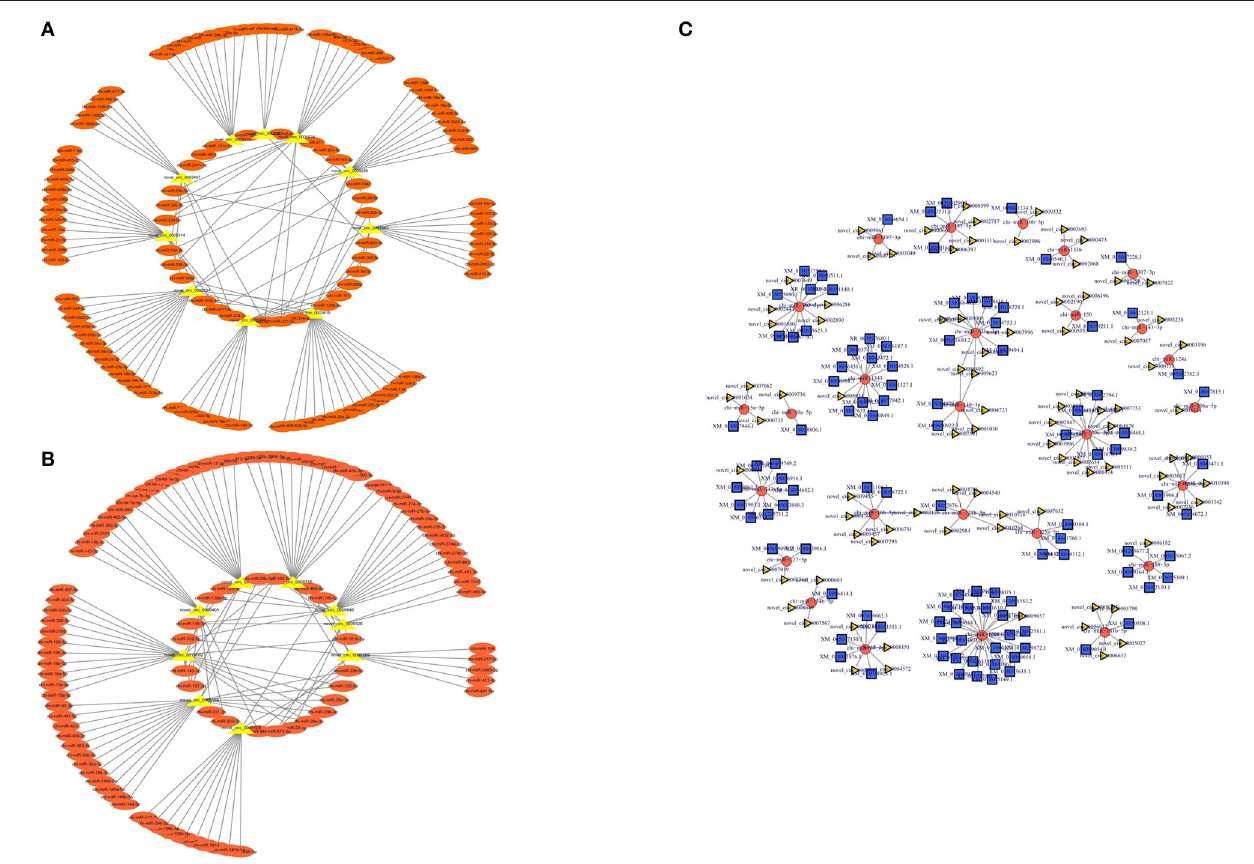
FIGURE 7 | circRNA-miRNA interaction network. (A) Significantly upregulated circRNAs and their targeted miRNAs. (B) Significantly downregulated circRNAs and their targeted miRNAs. (C) The circular RNA-miRNA-mRNA interaction network between circular RNAs and their target genes.